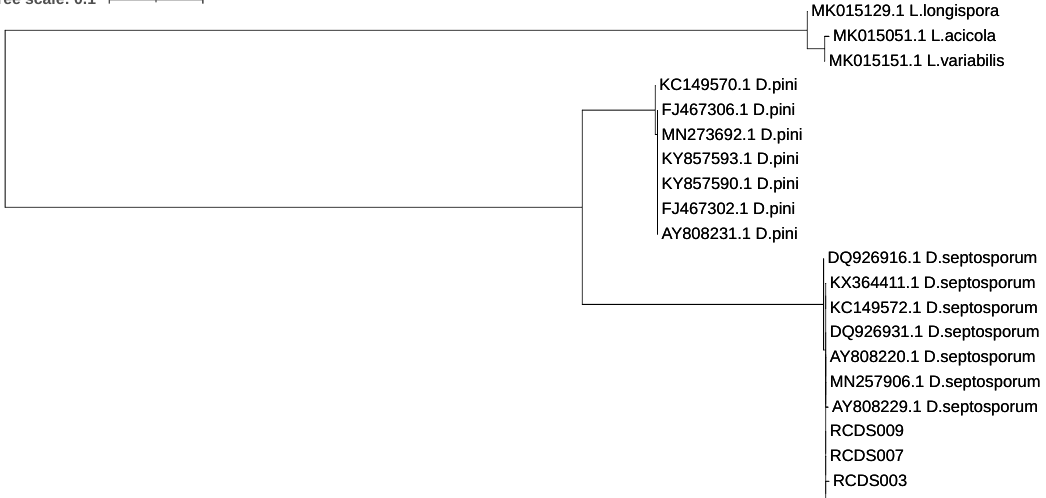
Figure 3. Phylogenetic tree with maximum likelihood score (branch support computed out of 1000 rapid bootstrapped trees) based on partial tub2 gene sequences of isolates RCDSS001, RCDS003, RCDS007, RCDS009 from Pinus nigra subsp. laricio in Prateria (San Pietro di Carid à , Reggio Calabria, Italy) and of Dothistroma species isolates retrieved from